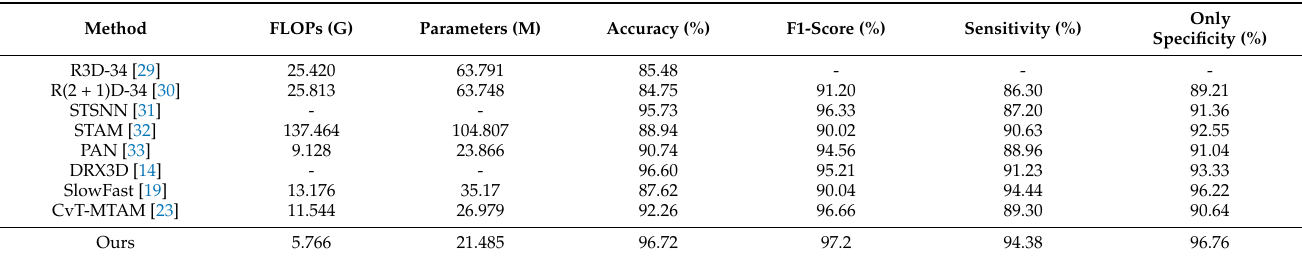
Table 2. Comparison of the proposed method on the Jester